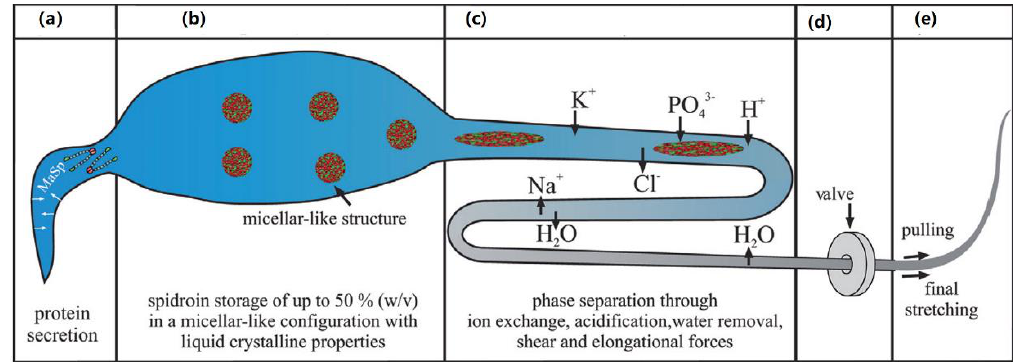
Figure 5. The spinning process that takes place in a spider’s spinning gland, reproduced with permission from Elsevier from Eisoldt et al. [49], where ( a ) is the tail, ( b ) is the ampulla (sac), ( c ) is the duct, ( d ) is the taper and ( e ) is the exterior.